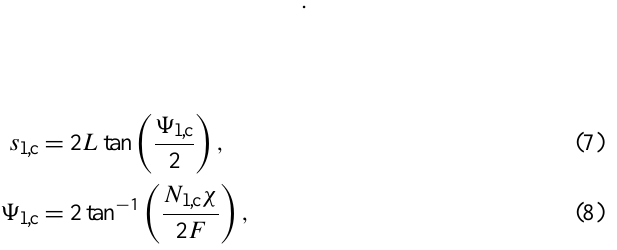
Figure 6. Measurement geometry for a thermal camera viewing a distant SO 2 plume (after Prata and Bernardo,